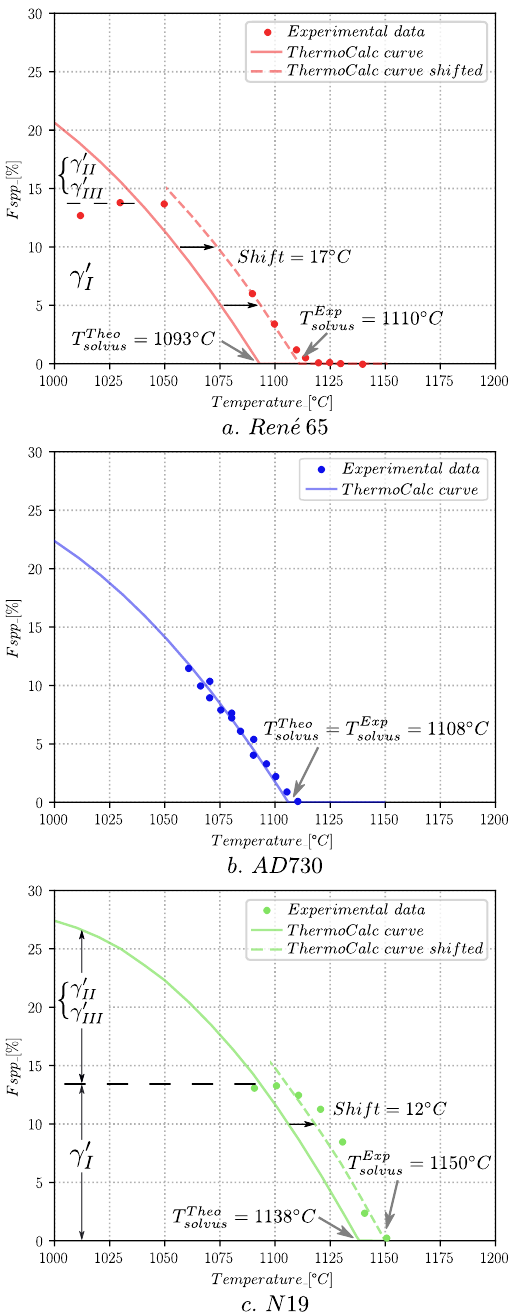
Figure 4. γ (cid:48) area fraction after 4 h annealing treatment as a function of temperature for alloys ( a ) René 65; ( b ) AD 730 and ( c ) N